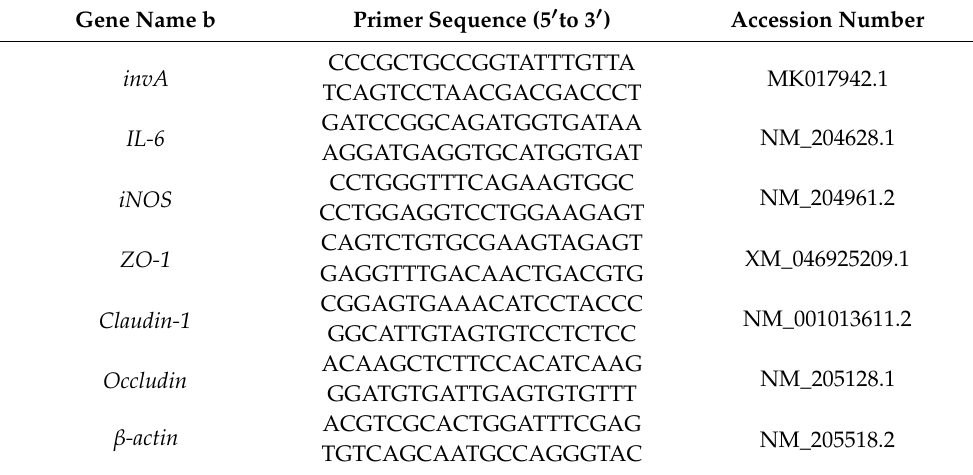
Table 1. Primers used for real-time PCR